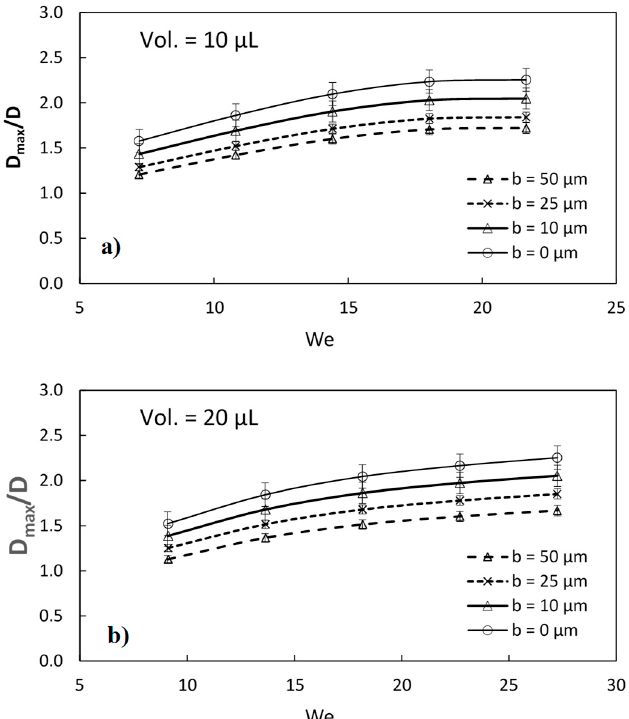
Figure 7. Normalized droplet maximum diameter ( D max / D) , D is spherical droplet diameter of the same volume) with Weber number for different micro-post spacings and droplet volumes: ( a ) 10 µ L and ( b ) 20 µ L. The micro-post spacing b = 0 represents the flat hydrophobized surface.